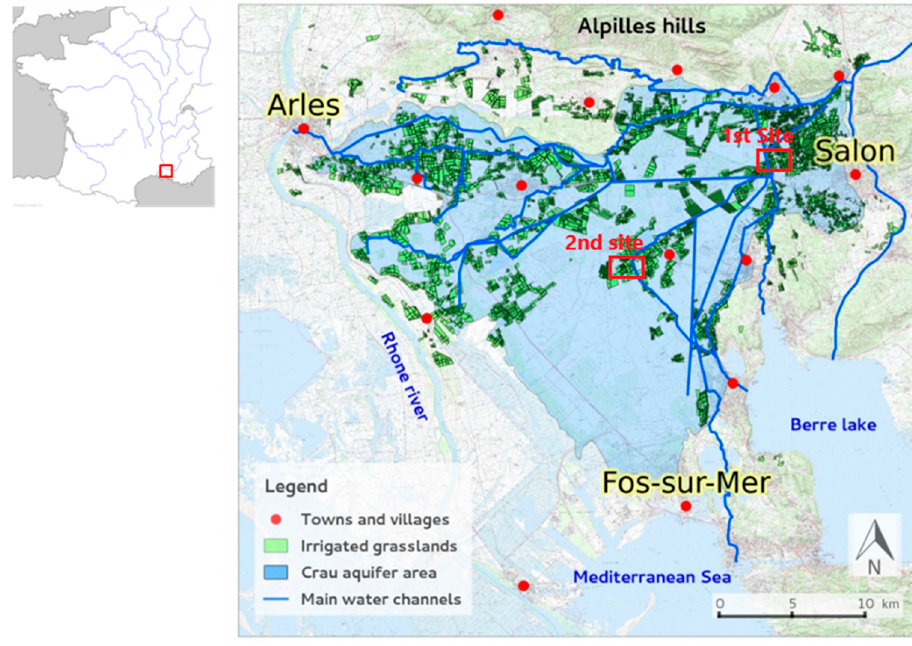
Figure 1. Map of the Crau area showing the aquifer limits, the irrigated grassland areas including the two monitored sites and the main surface water channels.